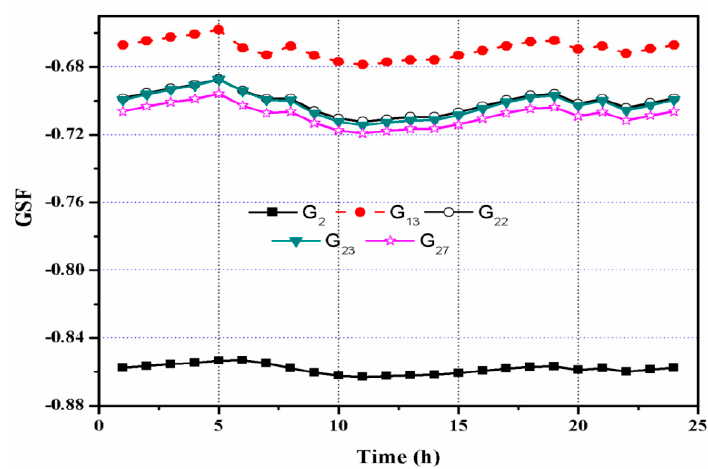
Figure 5. GSF with joint WF and PHS system for modified IEEE 30 bus system.